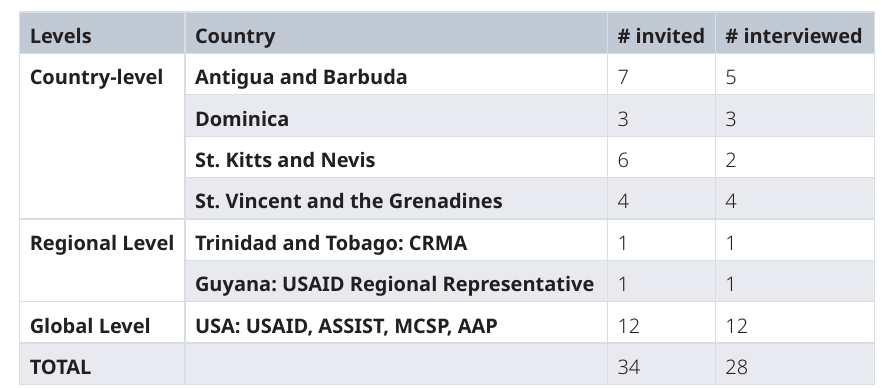
Table 1. Distribution of